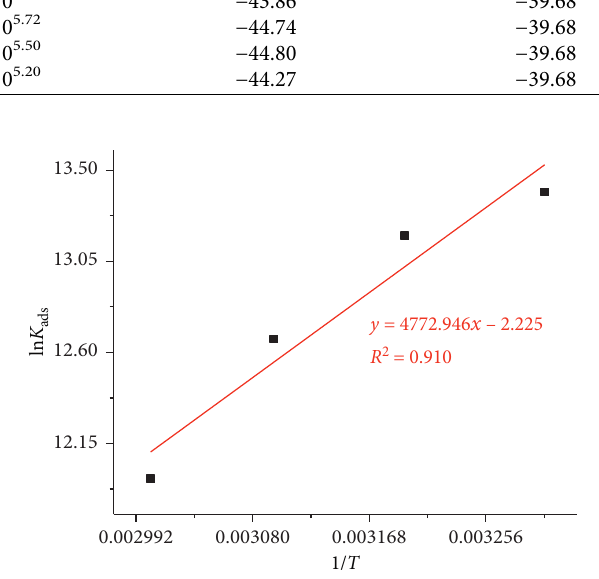
Figure 12: Relationship between ln K